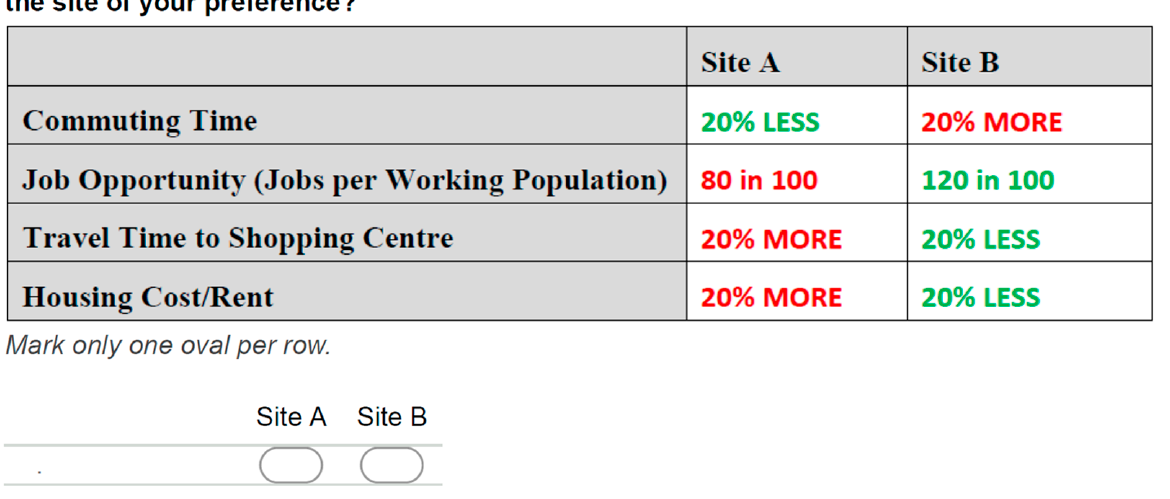
Figure 4. An example of the questionnaire on pairwise comparisons.